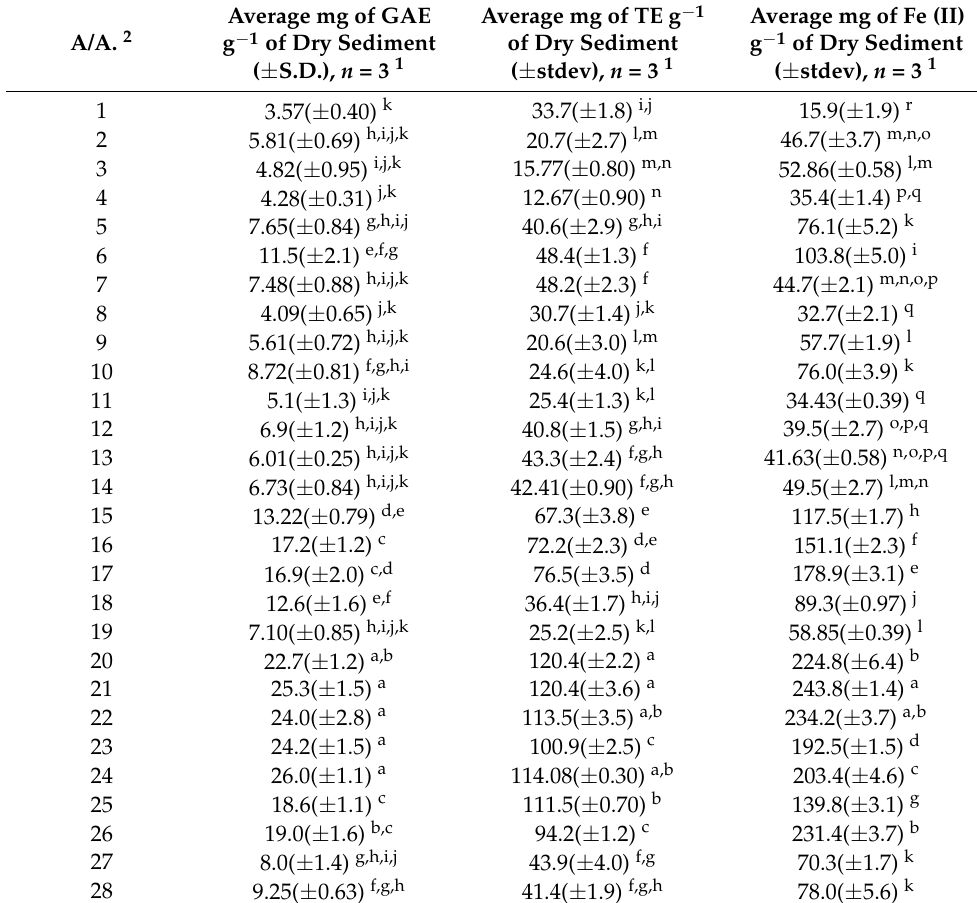
Table 3. Total phenolic content, antiradical activity by ABTS • + method and antioxidant activity by FRAP method for wine lees